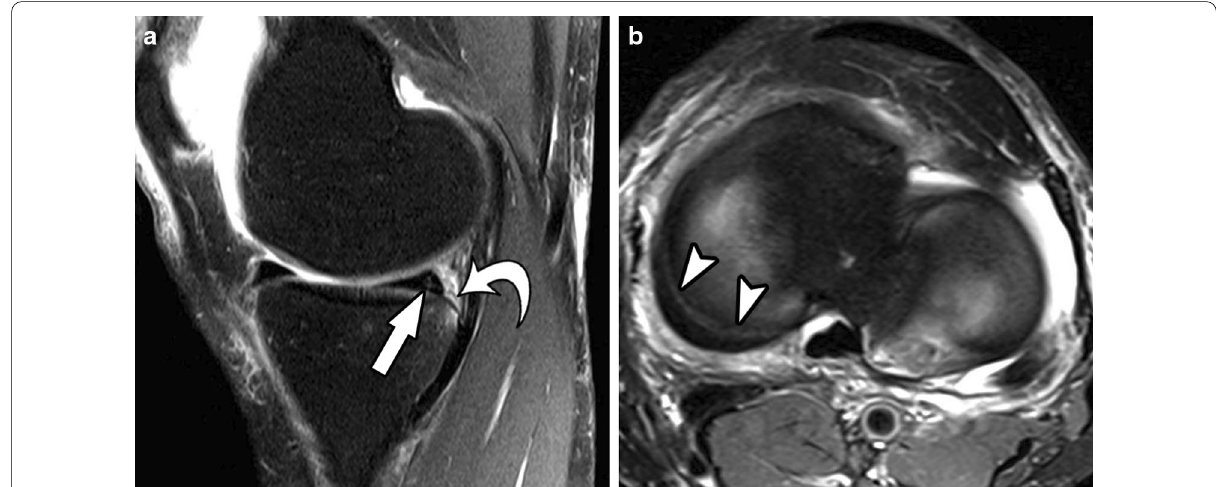
Fig. 9 Type 3B meniscal ramp lesion MRI Case. Sagittal ( a ) and axial ( b ) T2‑weighetd fat‑suppressed images show peripheral partial vertical tear affecting the tibial surface of the posterior horn of medial meniscus (arrow), along with meniscotibial ligament tear (curved arrow) and bone bruise; extension of vertical tear is seen in ( b )